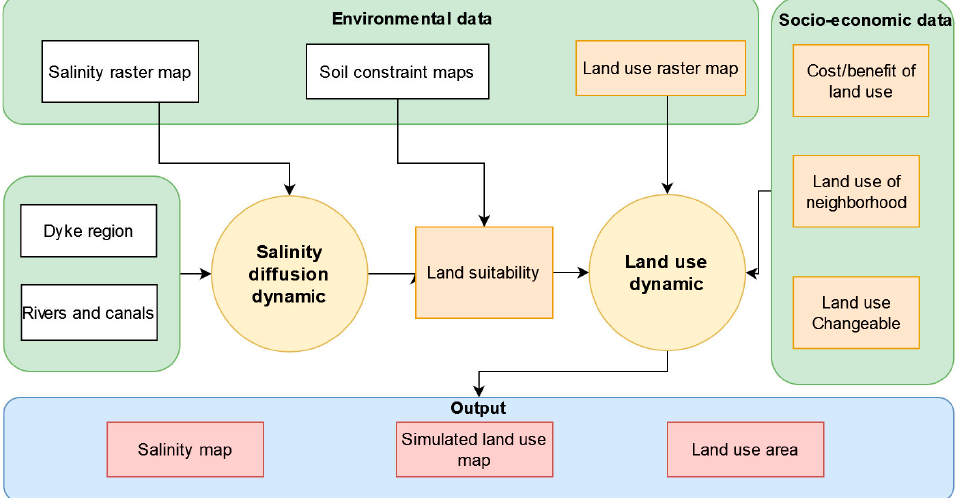
Figure 1. Conceptual model of MEKOLUC.